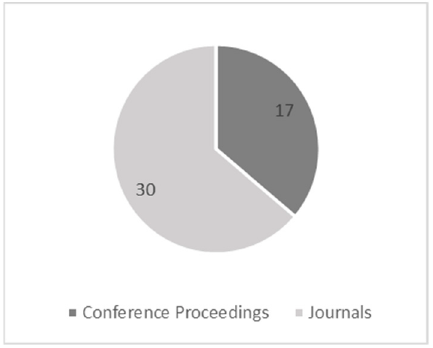
Figure 3. Articles Percentage by Publication Rank.